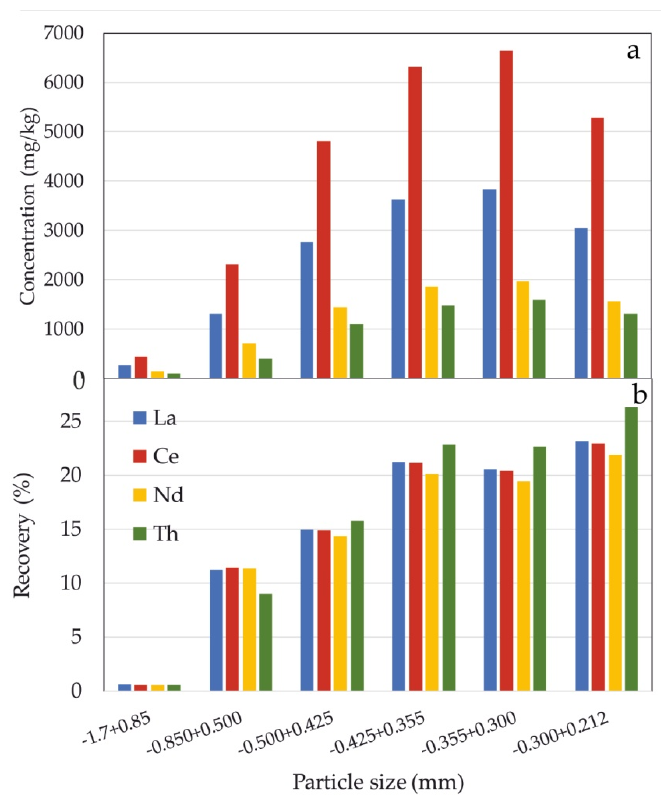
Figure 7. ( a ) LREE and Th distribution in the magnetic products of the particle size fractions and ( b ) metal recovery in each particle size fraction, based on mass balance calculations.